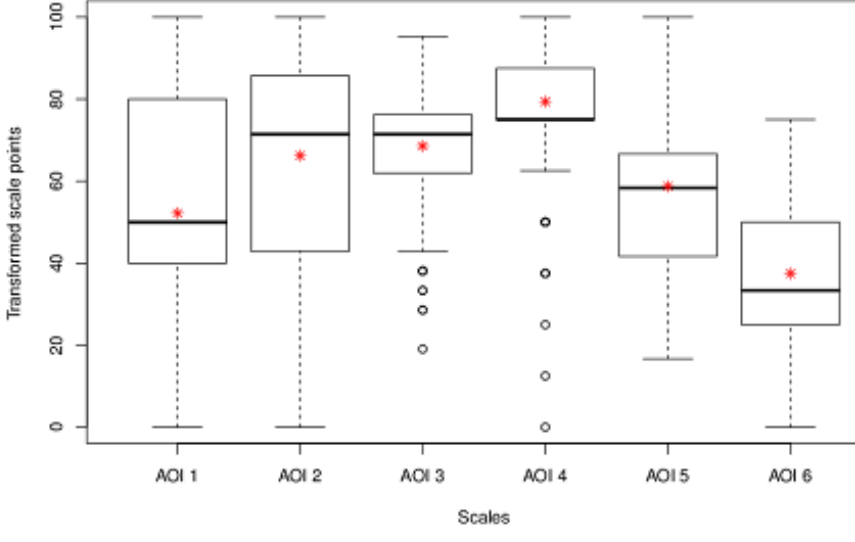
Figure 4. Scores for the different areas of interest (AOI) covered by the questionnaires. The asterisks indicate the mean value of the corresponding AOI.